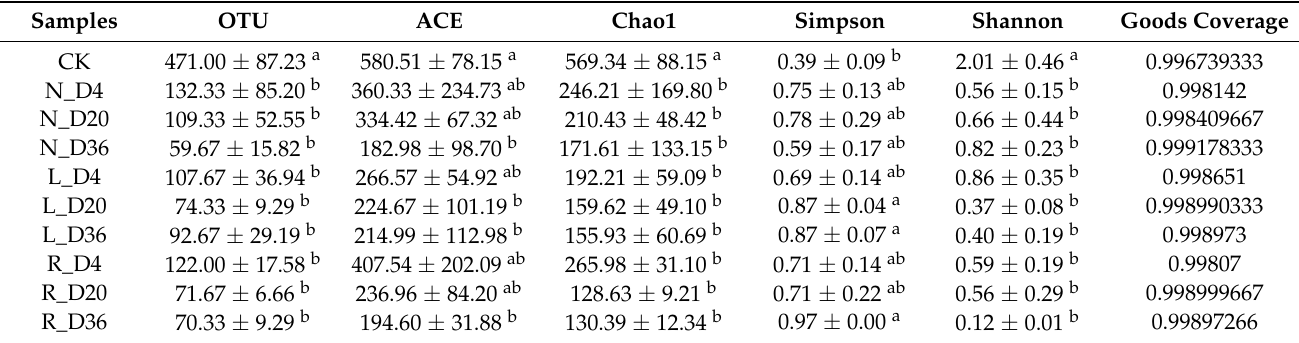
Table 3. Alpha diversity indexes in samples of the fermented